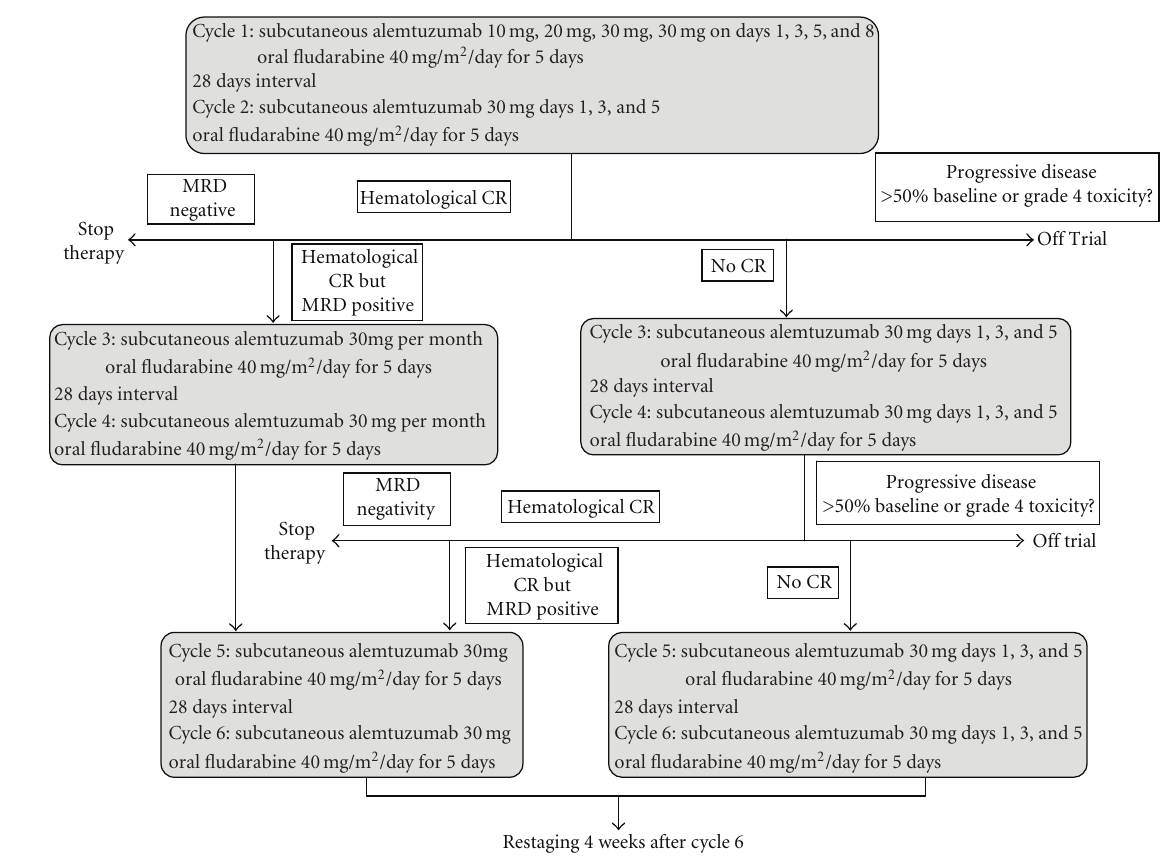
Figure 1: OFSA Treatment schedule. CR: Complete remission, MRD: Minimal residual